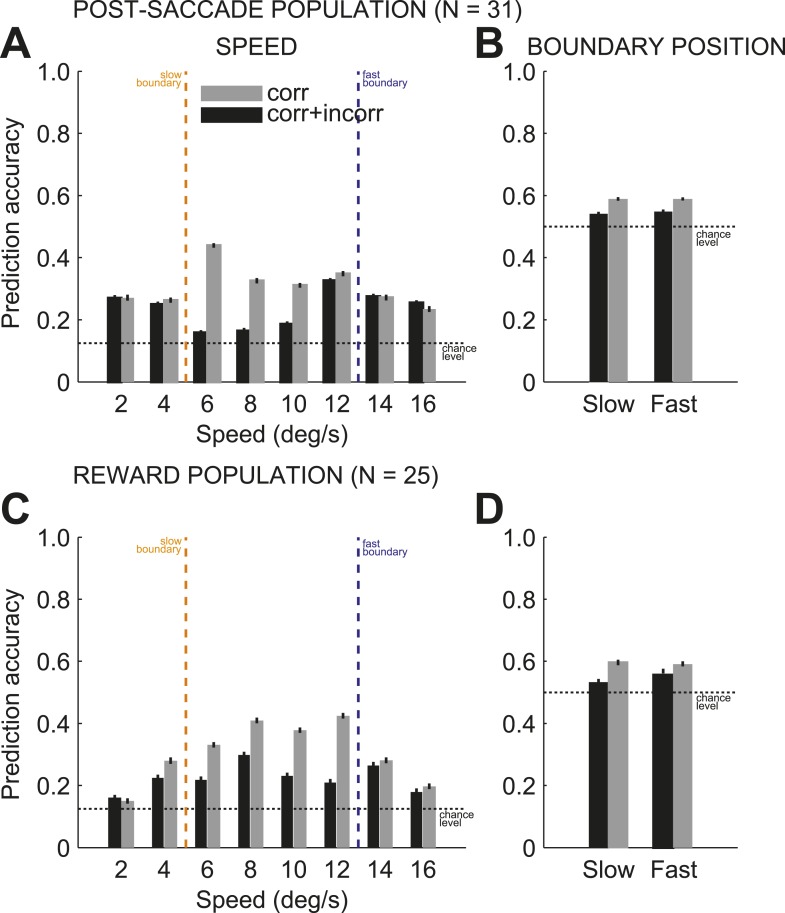
Prediction accuracy for speed and category boundary.The average prediction accuracy for speed (A, C), across two boundary position, and boundary position (B, D), across all speeds, for correct only trials (black) and all trials (correct and incorrect, gray) separately for the post-saccade (A, B) and reward (C, D) neuronal populations. Corresponding chance levels are shown in dashed line. Orange/blue dashed lines, actual slow/fast boundary positions.